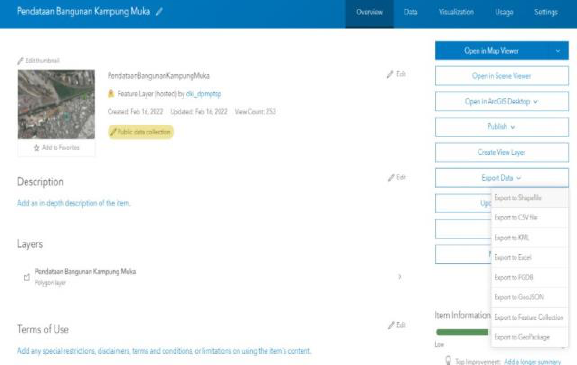
Figure 10 . Database Portal of Web-GIS application